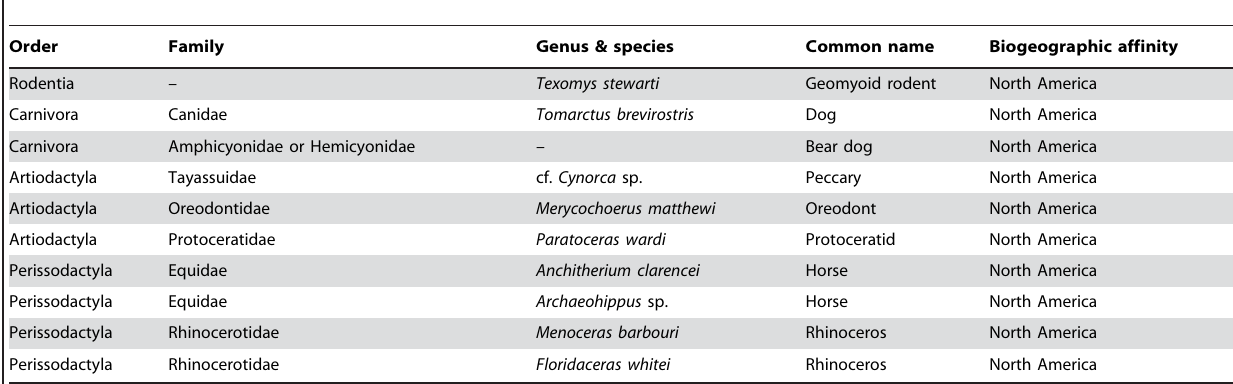
Table 1. Land mammal taxa from the Gaillard Cut Local Fauna, Cucaracha Formation, Panama.